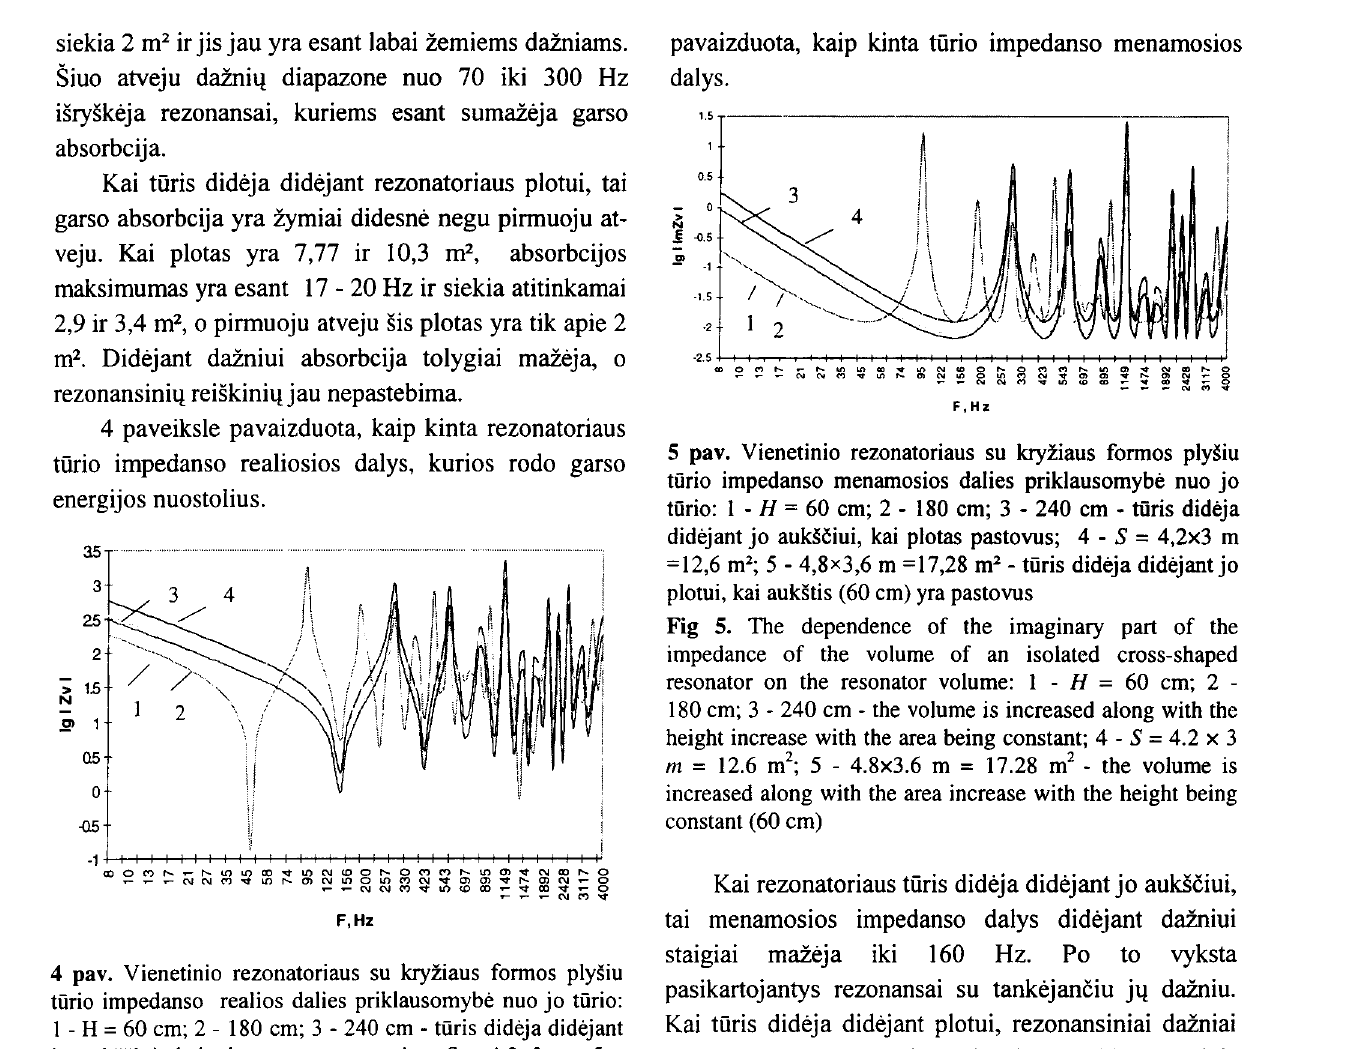
Fig 4. The dependence of the real part of the impedance of the volume of an isolated cross-shaped resonator on the resonator volume: I - H = 60 em; 2- 180 em; 3 - 240 em the volume is increased along with the height increase with the area being constant; 4 - S = 4.2x3 m; 5 - 4.8x3.6 m - the volume is increased along with the area increase with the height being constant (60 em)